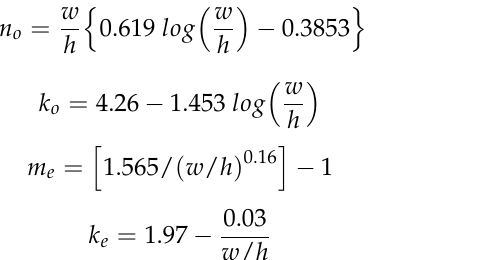
Figure 2. Circuit model representation of the microstrip line with a gap without film deposition.